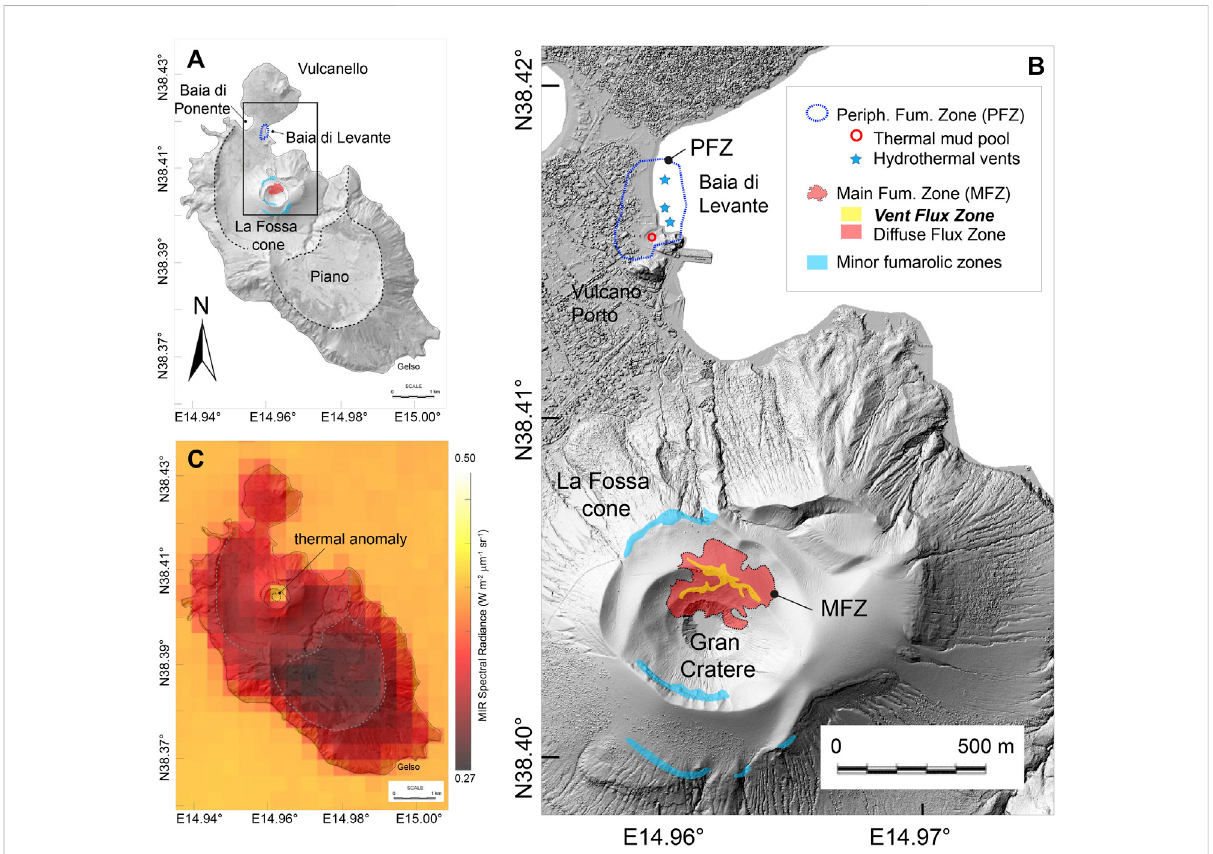
FIGURE 1 (A) Sketch map of Vulcano Island, the southernmost island of Aeolian Archipelago, showing the location of La Fossa cone and the Baia di Levante. (B) DetailoftheGranCratereandthenorth fl ankofLaFossacone,showingtheapproximateoutlines oftheMain FumarolicZone(MFZ) and the Peripheral Fumarolic Zone (PFZ) (modi fi ed from Diliberto 2011, 2017, 2021, Madonia 2020; Müller et al., 2021; Mannini et al., 2019). Following Mannini et al., 2019, the MFZ (inside the Grand Cratere) is subdivided into two distinct zones: (1)the vent fl ux zone (in yellow) and (2) the diffuse fl ux zone (in red). Minor fumarolic zones surrounding the Gran Cratere are shown in light blue; The PFZ is located in the Vulcano Porto area. Hydrothermal manifestations in this area consist of a thermal mud pool (red circle) and several hydrothermal vents (blue stars)in the Baia di